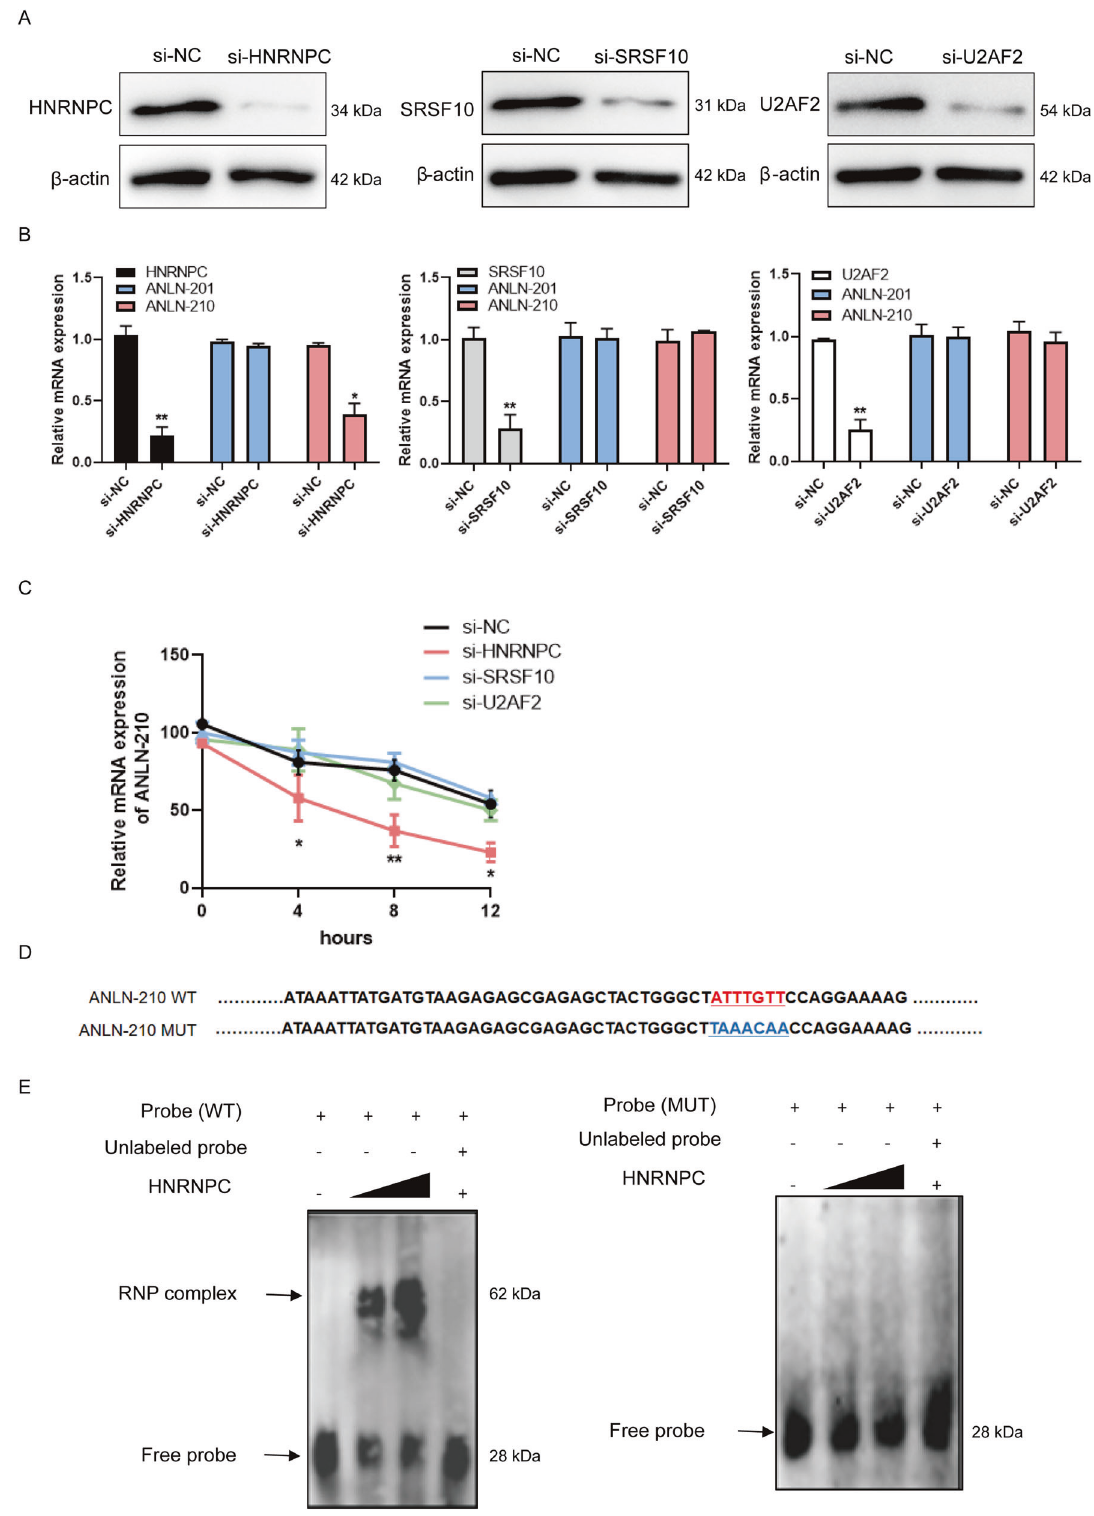
Fig. 5 ANLN-210 interacts with HNRNPC. A The knockdown ef fi ciency of si-HNRNPC, si-SRSF10, and si-U2AF2 was assessed at protein level by western blot. B The RNA levels of ANLN-201 or ANLN-210 were measured in si-HNRNPC, si-SRSF10, and si-U2AF2 transfected cells by qRT-PCR. * P < 0.05, ** P < 0.01. C The RNA stability of ANLN-210 was evaluated in si-HNRNPC or si-SRSF10 or si-U2AF2 treated with actinomycin D after 4, 8, and 12 h. * P < 0.05, ** P < 0.01. D Schematic representation of the ANLN-210 WT and ANLN-210 MUT sequences used as probes in EMSA. MUT: The binding sequences between ANLN-210 and HNRNPC were mutant. ANLN-210 MUT could not interact with HNRNPC. E SCC-9 cells were transfected with HNRNPC in a dose-dependent manner. EMSA was performed using ANLN-210 WT probe (left) and ANLN-210 MUT probe